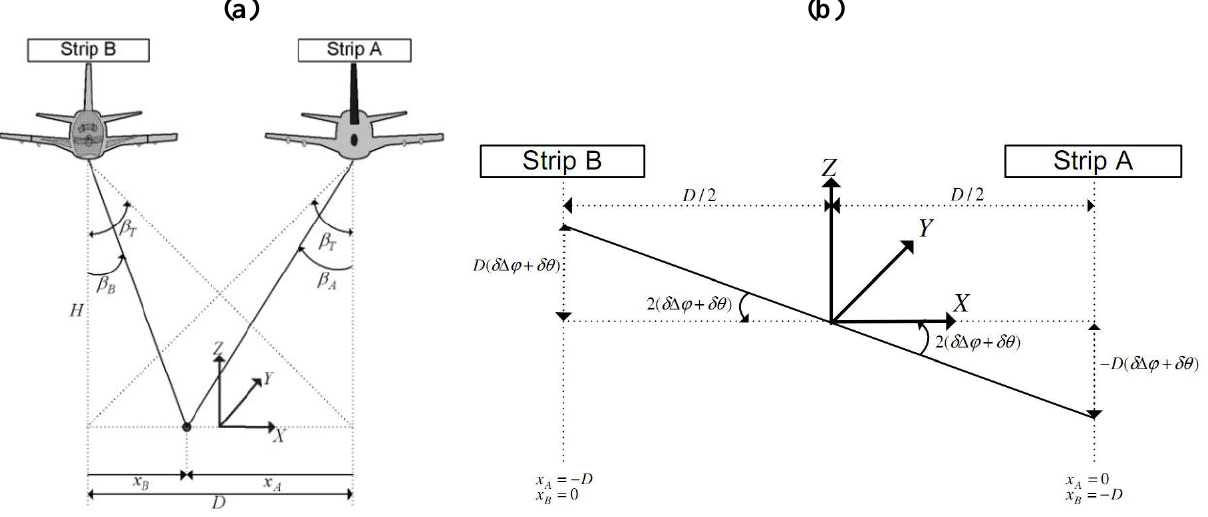
Figure 2. (a) Observed object point in overlapping strips flown in opposite directions. (b) The introduced tilt across the flight direction by the boresight roll bias and the scan angle scale